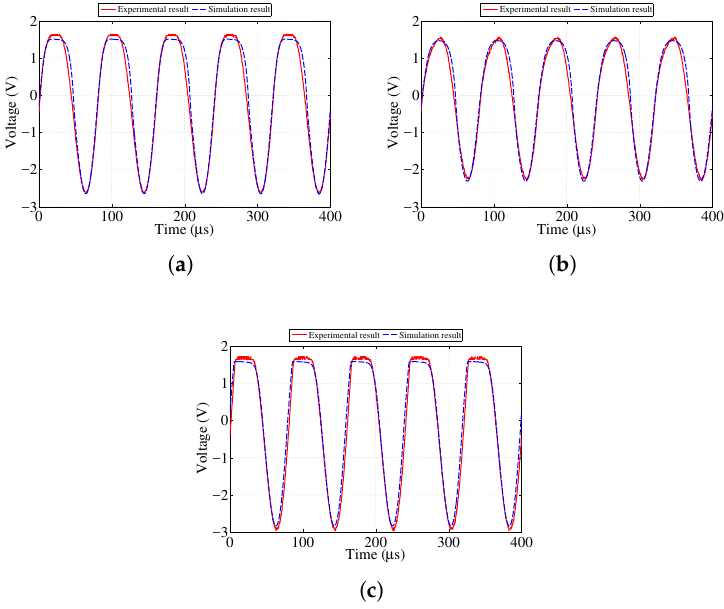
Figure 6. Simulation and experimental voltage data across 0.5 mm strip LED showing response at various resistances. ( a ) 3.8 k Ω resistance (at threshold); ( b ) 6.7 k Ω resistance (above threshold); ( c ) 0.6 k Ω resistance (below